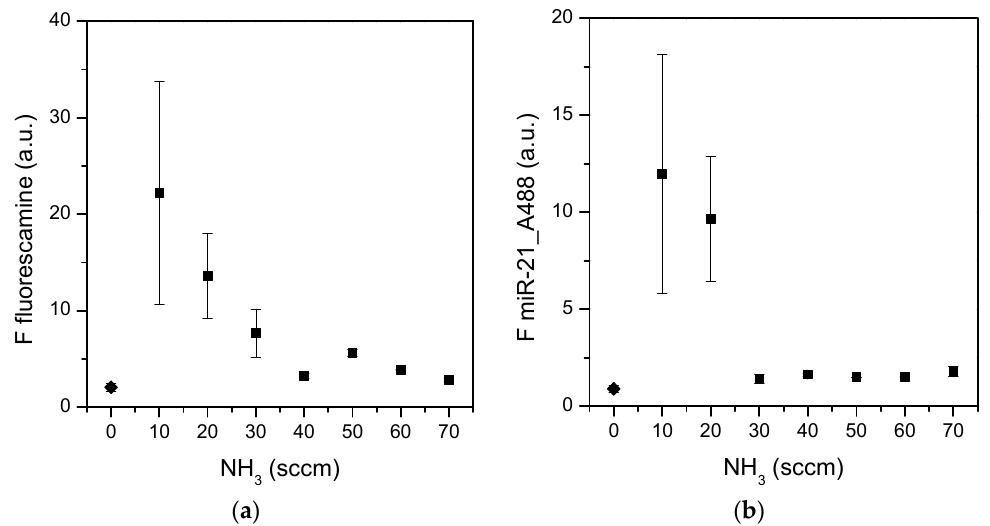
Figure 1. Fluorescamine assay ( a ) and miR-21 adsorption ( b ) on surfaces plasma-processed with CH 4 /NH 3 feeds. The fluorescence signal (squares) is plotted versus the concentration of NH 3 in the feed. Values at 0 sccm (diamonds) are control surfaces (untreated silicon). Data are means of at least three surfaces, while the standard error is also presented ( n ≥ 3).